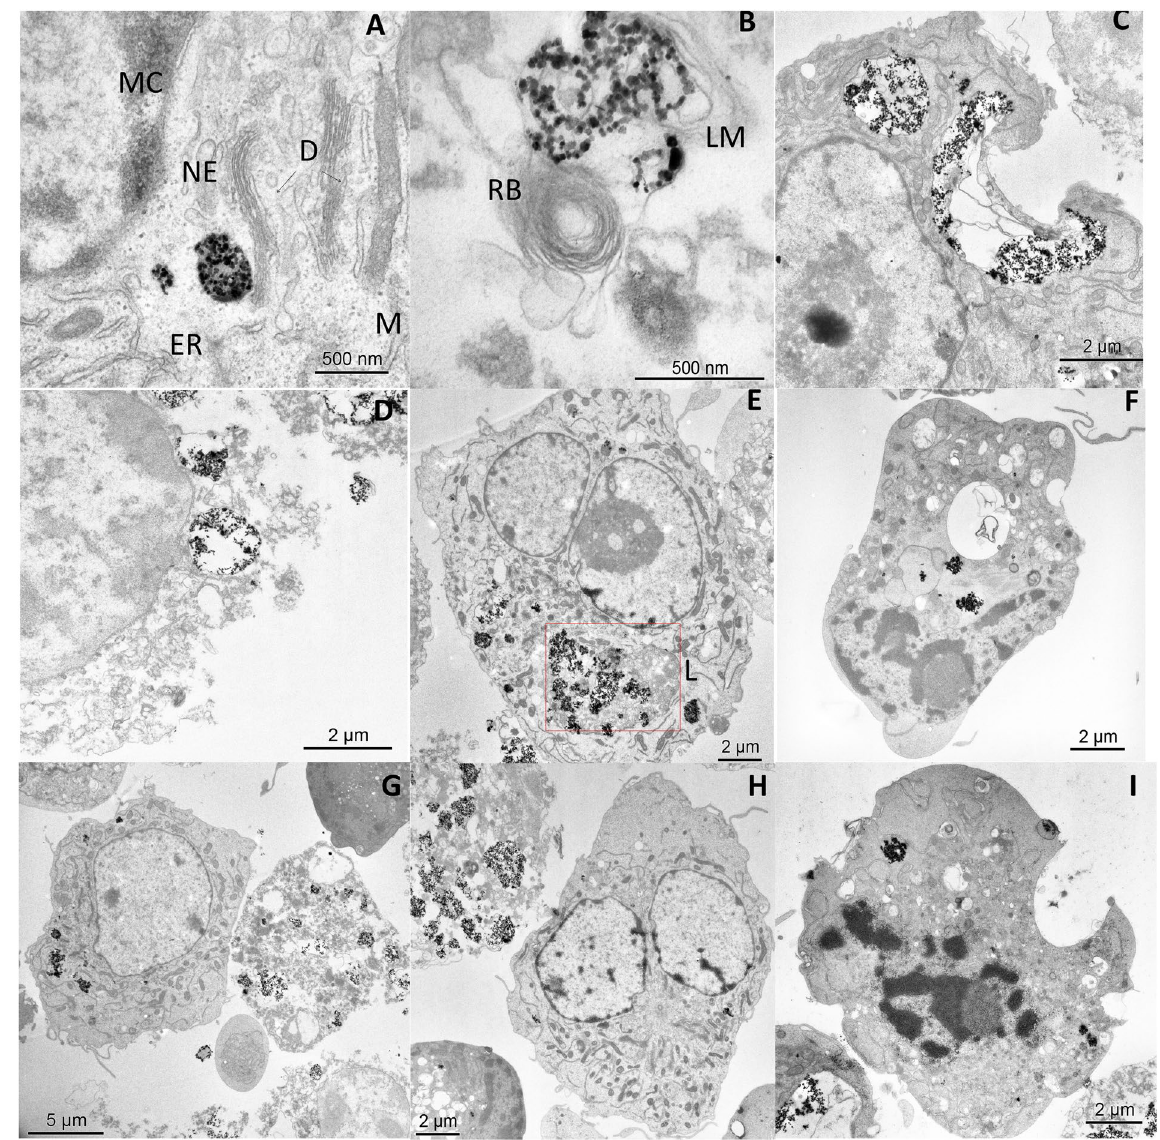
Figure 8. TEM images of BV2 cells containing 100 µ g/ml of PAA-MNPs after 30 min of MHT at 46 °C. ( A ) vesicle-containing MNPs, ER: endoplasmatic reticulum, NE: nuclear envelope, MC: marginal chromatine, ( D ) dictyosome and M: mitochondrie. ( B ) MNPs cluster wrapped in lysosomal membrane (LM) and close to a residual body (RB). ( C ) Disrupted cell membrane near a large PAA-MNPs cluster after MHT. ( D ) Typical image of a completely damaged cell due to AMF and PAA-MNPs. ( E ) Cell with lysosome containing PAA-MNPs. Apoptotic cells ( F and I ) and dead cells ( G and H ) were found to coexist after MHT with (seemingly) alive cells containing high variable amounts of PAA-MNPs